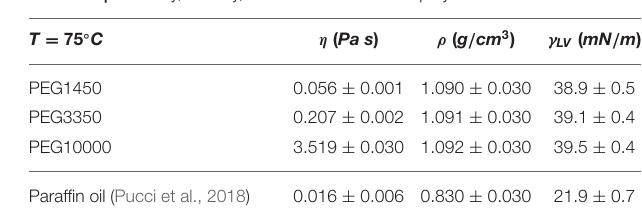
TABLE 1 | Viscosity, density, and surface tension of polymers at T = 75 ◦ C.